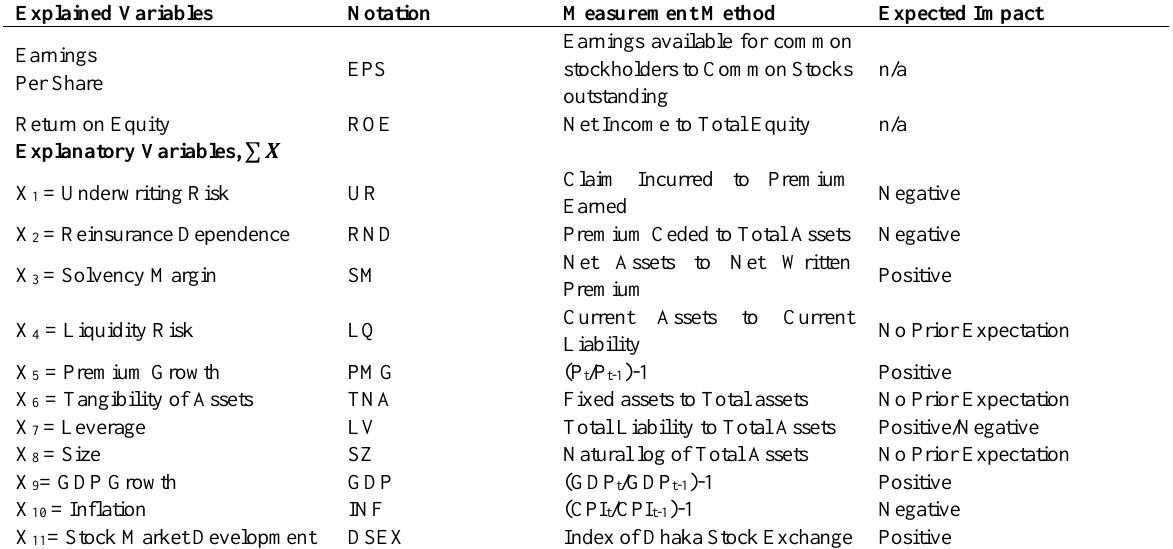
Table 1: A description of the variables that make up the